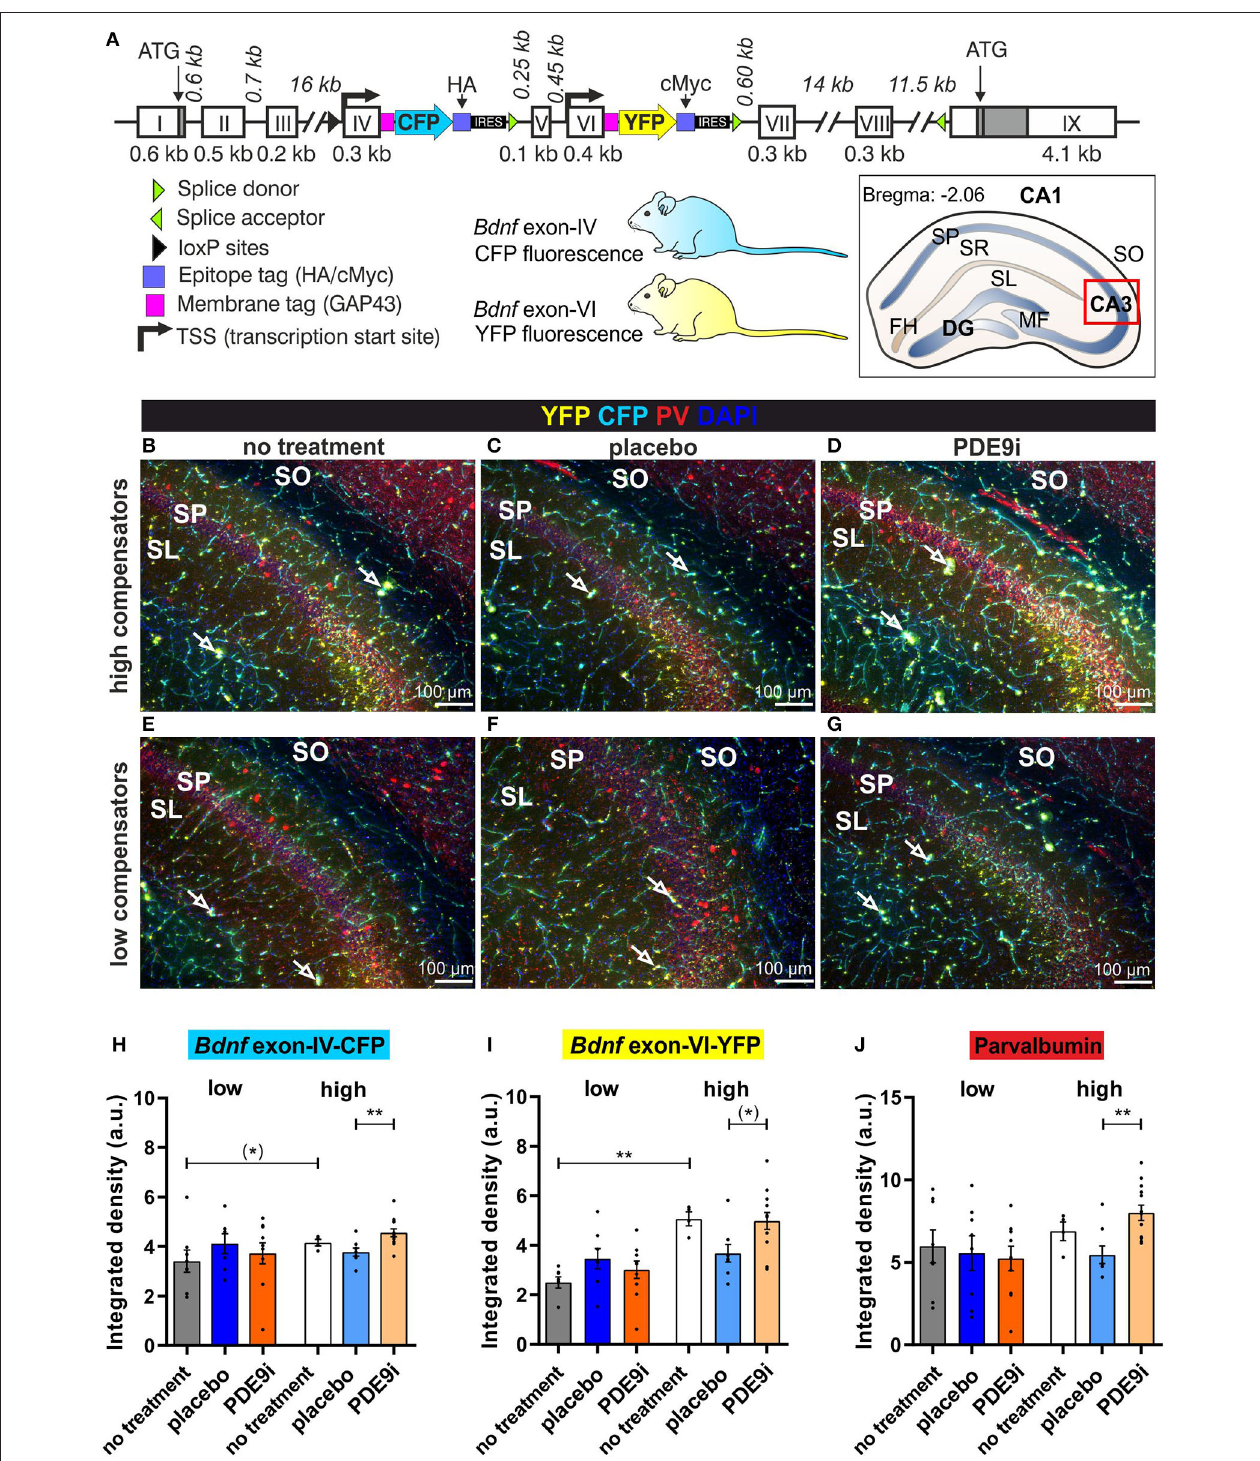
FIGURE 7 | Bdnf exon-IV, Bdnf exon-VI, and Parvalbumin (PV) expression in the CA3 region of the hippocampus of untreated low and high compensators and animals that received placebo or PDE9i. (A) Genetically modified the Bdnf gene of the BLEV reporter mouse line in which CFP is expressed with activity-dependent Bdnf exon-IV transcription and YFP with activity-dependent Bdnf exon-VI transcription. An abstract scheme of a coronal hippocampal section at bregma position